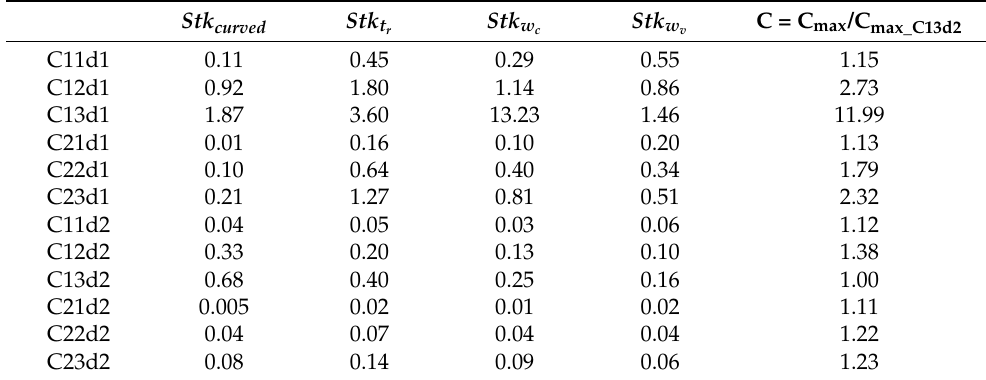
Table 6. Cases studied and their corresponding maximum concentration within the elbow. Table 7. Cases studied and their corresponding Stokes numbers.